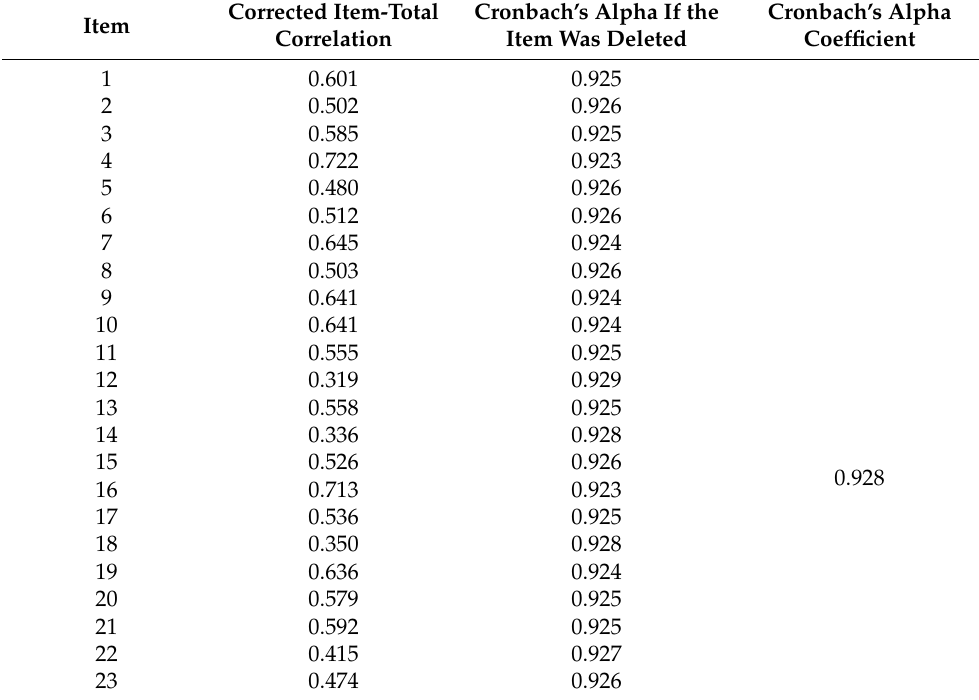
Table 3. Cronbach’s alpha coefficient of the GDS-30 scale ( n =